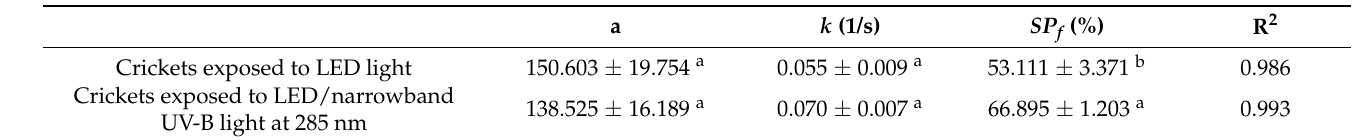
Table 2. Estimates of the parameters of Equation (4) (survival percent as a function of rearing time) that were applied to the average data obtained from the cricket Acheta domestica rearing with the two irradiation regimes.